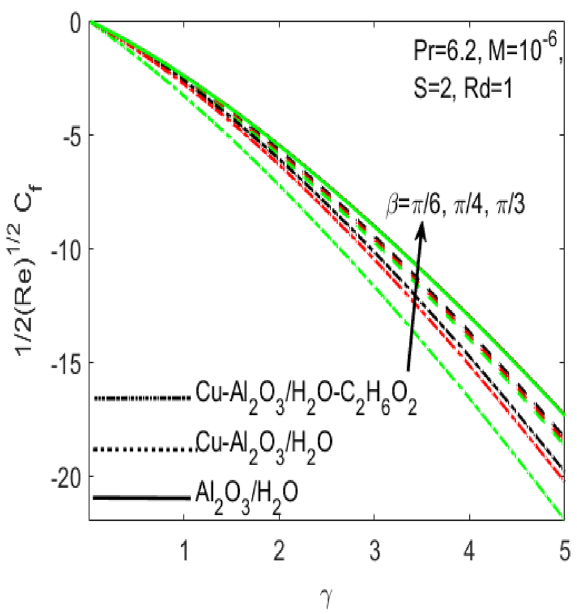
Figure 13. Influence of β on C f for different hybrid nanofluids and simple